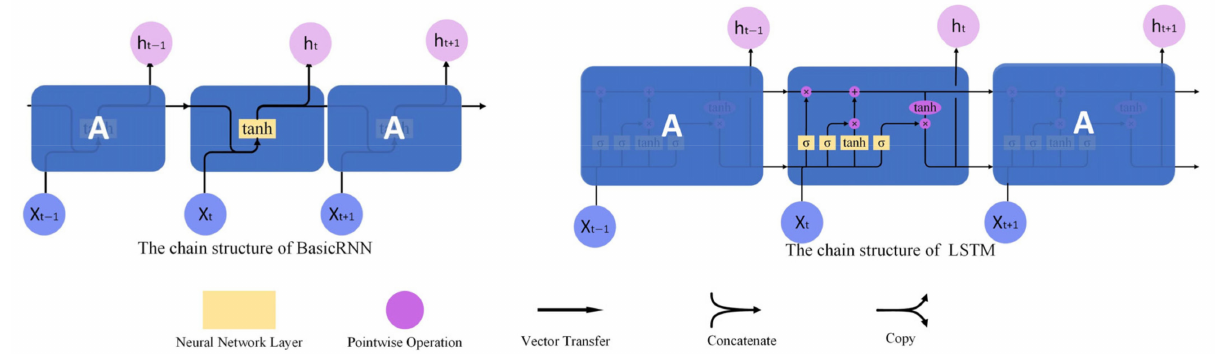
Figure 4. The chain structures of two typical recurrent neural networks. The arrow represents passing a complete vector, and the yellow box represents the neural network layer; Purple circles represent point-by-point operations; A merge line means that two inputs are in series, and a forked line means that content is sent to different